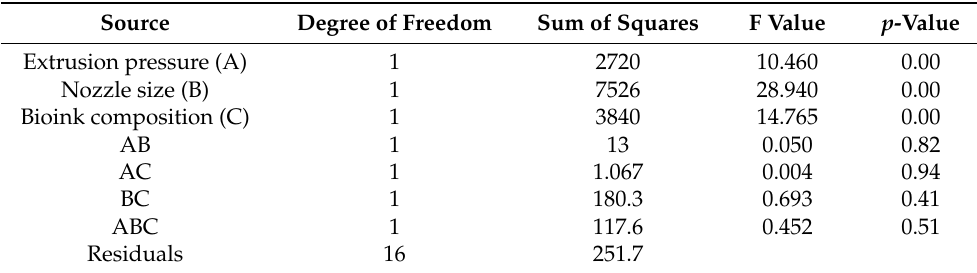
Table 7. ANOVA Table for effects on living cell concentration (cell